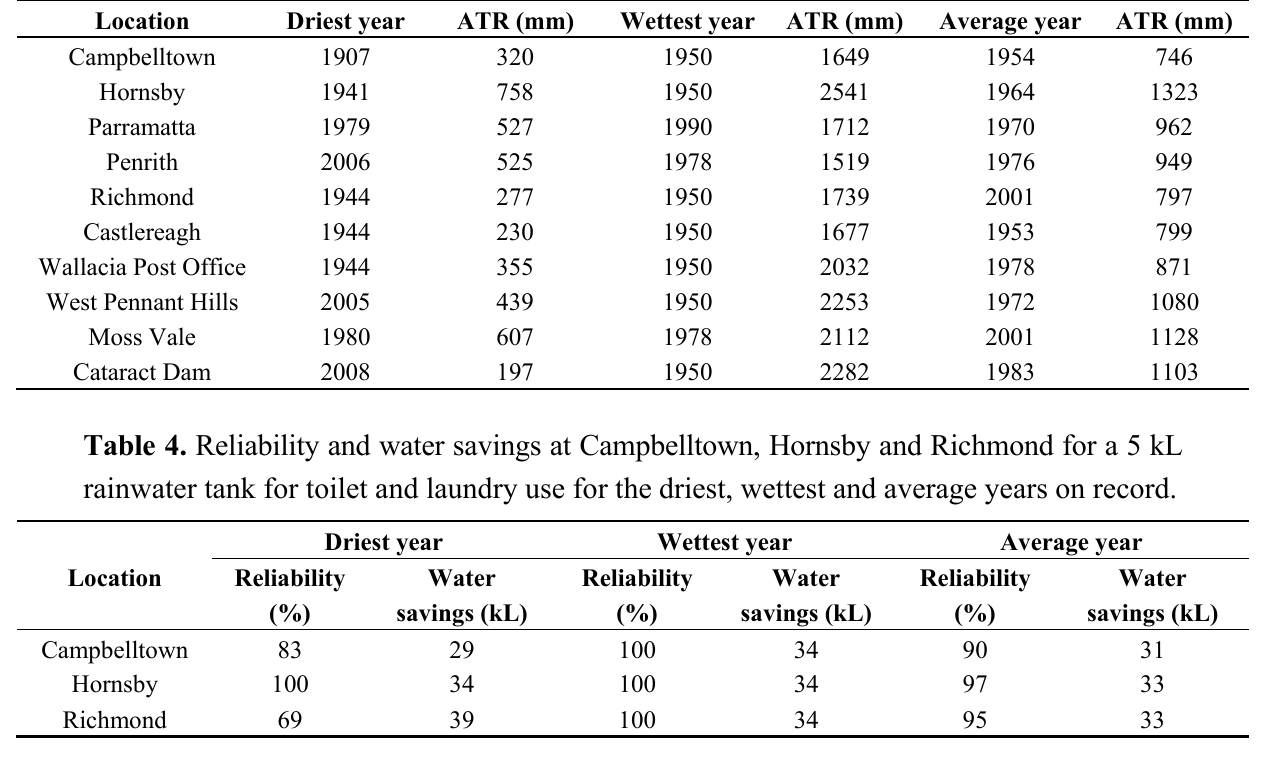
Table 3. Annual total rainfalls (ATR) in the wettest, driest and average years on record for the ten locations.